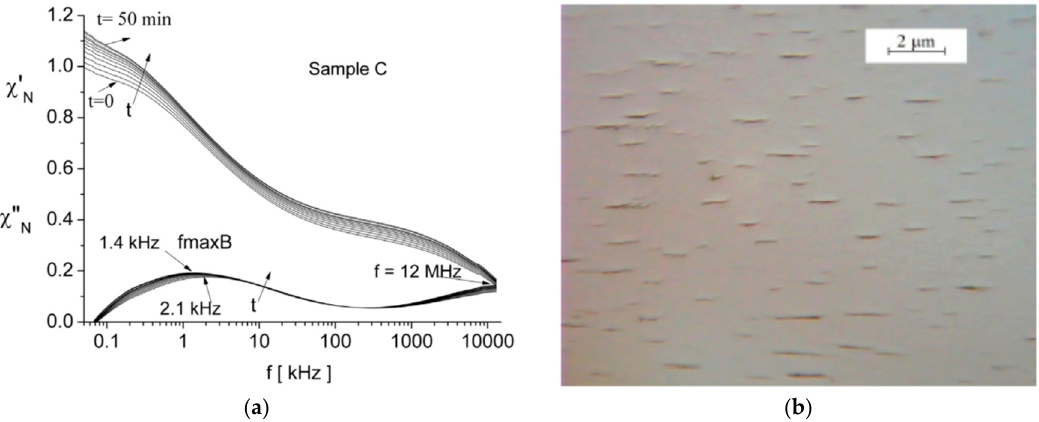
Figure 11. ( a ) Frequency dependence of the normalized components of the complex susceptibility of a ferrofluid sample and ( b ) optical microscopy image of magnetically induced phase separation. Reprinted with permission from Reference